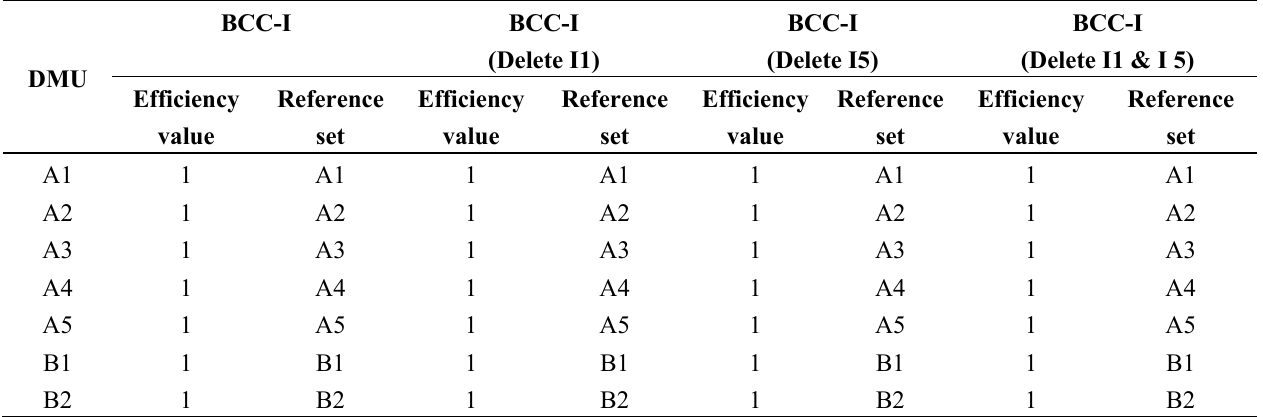
Table 6. Results for BCC-I after deleting